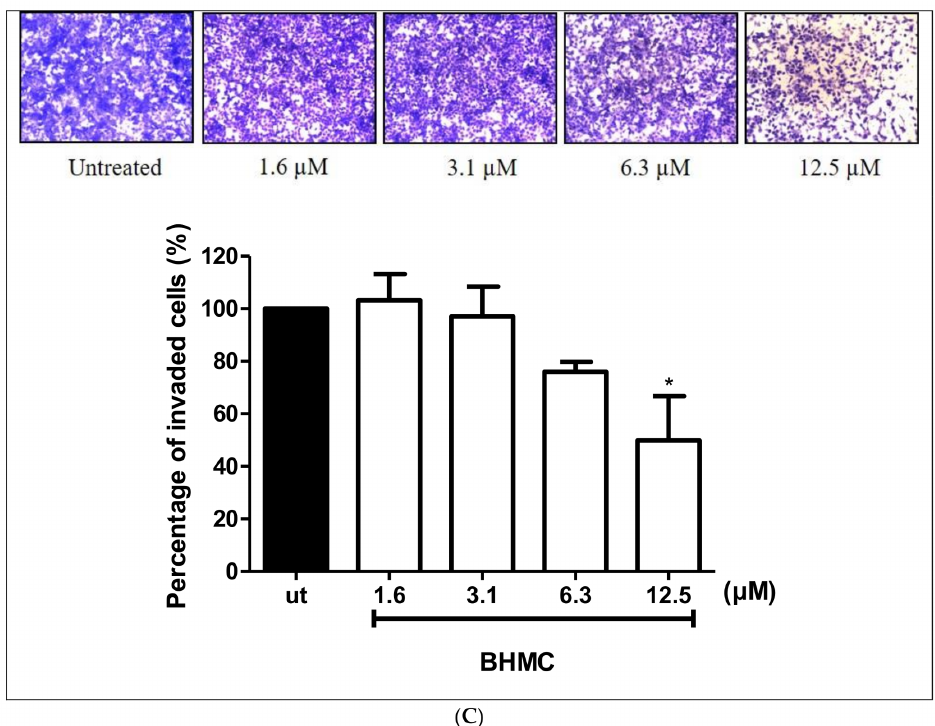
Figure 2. Effects of BHMC on the migration and invasion of MDA-MB-231 cells using scratch migration assay, transwell migration, and transwell invasion assays. ( A ) Confluent MDA-MB-231 cells were wounded with a vertical pipette tip and treatment of BHMC of indicated concentrations were added for 24 h. The cells were photographed under inverted microscopy at 0 h and at 24 h. The distance the cells migrated were calculated and converted into a percentage. The outer dotted line is the mark of the distance at 0 h while the black line is the mark of distance at 24 h. ( B ) MDA-MB-231 cells were seeded into 8 µ m transwell inserts and treated with indicated concentrations of BHMC for 24 h. The cells were stained with 0.2% crystal violet. The images were captured at five different fields using a magnification of 100X. The stained cells were lysed with 100% acetic acid and absorbance was measured at 570 nm. ( C ) For transwell invasion, the MDA-MB-231 cells seeded on rat-tail collagen type I in 8 µ m inserts were treated with the indicated concentrations of BHMC for 24 h. The cells were then stained with 0.2% crystal violet. The images were captured at five different fields using a magnification of 100X. Then, the dye was lysed with 100% acetic acid and the absorbance was measured at 570 nm. The data represents the mean ± S.E.M of three independent experiments. * p < 0.05 and ** p < 0.01, which is significantly different from the untreated